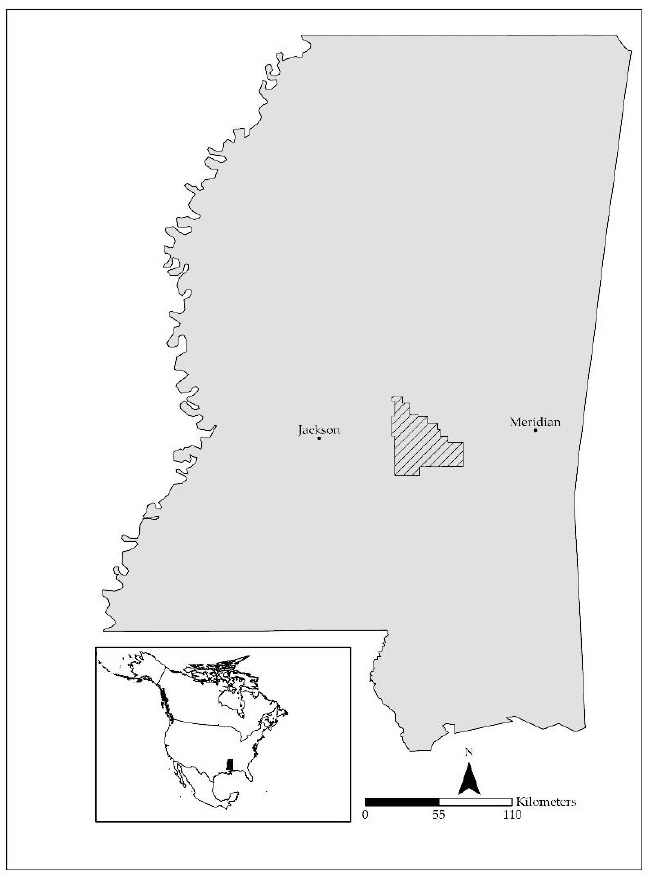
Figure 1. Map showing the relative location of the Bienville National Forest (hatched area) in Mis-